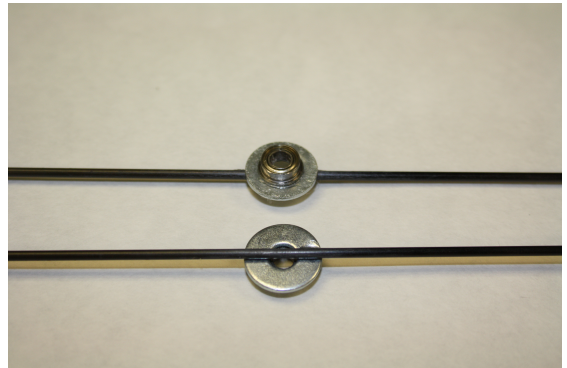
Figure 3. Detail of the union of the fibre carbon rod, washer, and ball bearing.